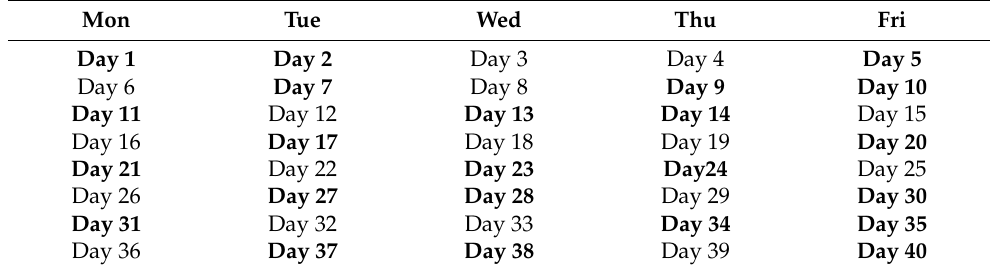
Table A1. Calendar with the days when the contents were